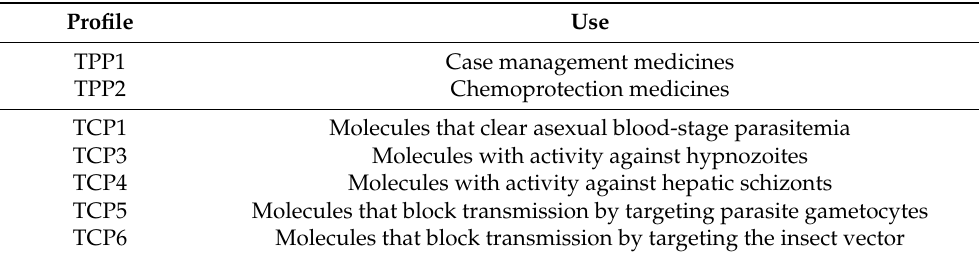
Table 1. Updated description of TPPs and TCPs. Adapted from [114], Springer Nature,